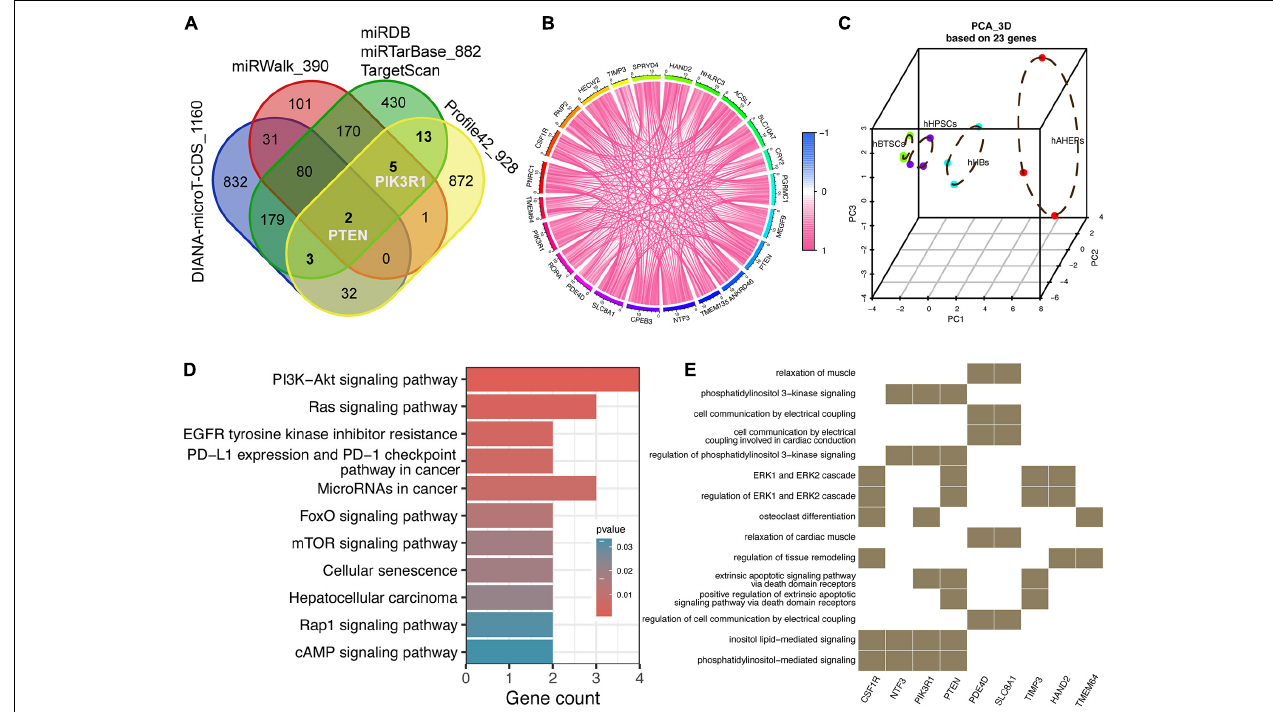
FIGURE 3 | Prediction and function analysis of upwardly expressed targets according to the key miRNAs. (A) Venn plot of potential targets from five miRNA-related databases and 928 lineage-specific mRNAs. (B) Correlation analysis among 23 targets. (C) 3D PCA analysis of four stages of hepatic lineage based on 23 targets. (D) KEGG analysis of 23 targets. (E) GO analysis of 23